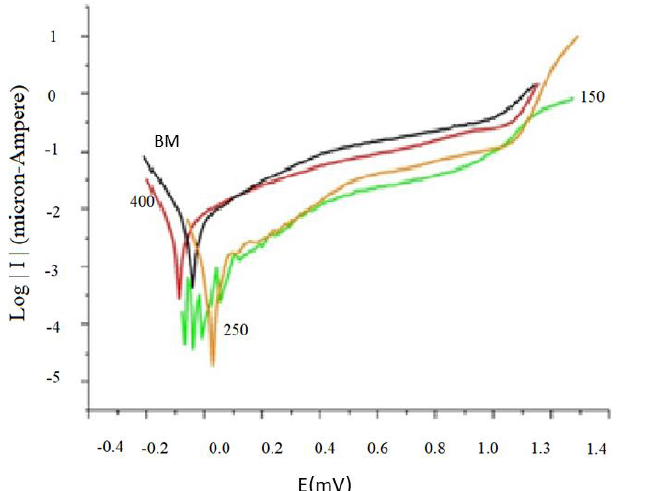
Figure 9. Comparative polarization curves of the heat-affected zone (HAZ) for different inter-pass temperatures (150 o C, 250 o C, and 400 o C), with the base metal as